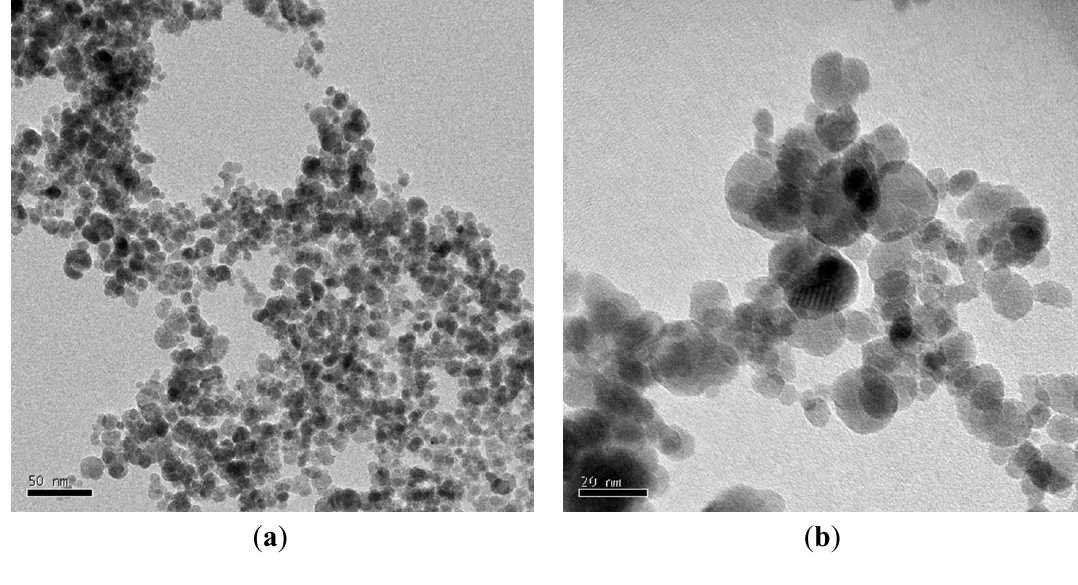
Figure 11. TEM images of magnetite nanoparticles (10 nm) at low ( a ) and high ( b )